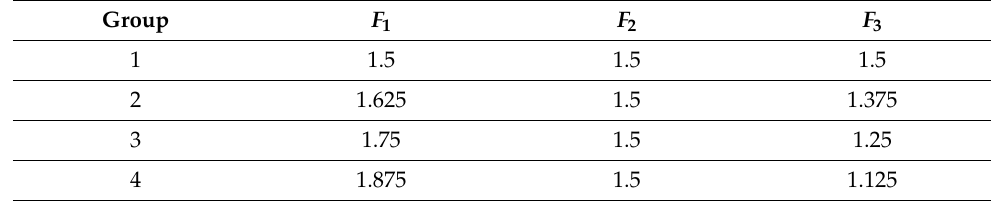
Table 1. F k of charger in each region with M = 0.5.